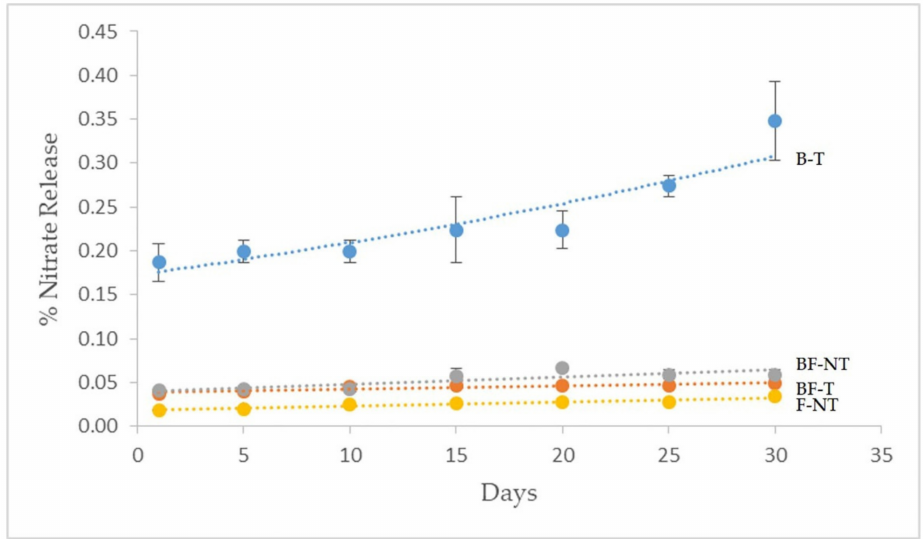
Figure 5. Percent nitrate release of total N applied at five day intervals for 30 days of a water incubation